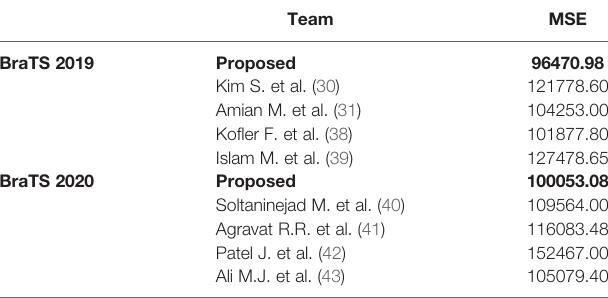
TABLE 8 | Comparison of the results of survival prediction task.